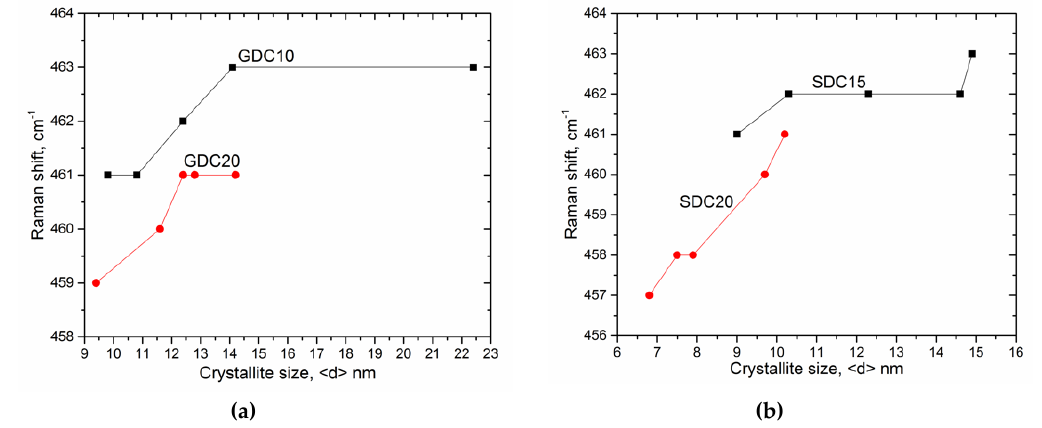
Figure 8. Change of the F 2g mode peak position with respect to crystallite size for ( a ) GDC10, GDC20 samples; ( b ) SDC15, SDC20 samples.